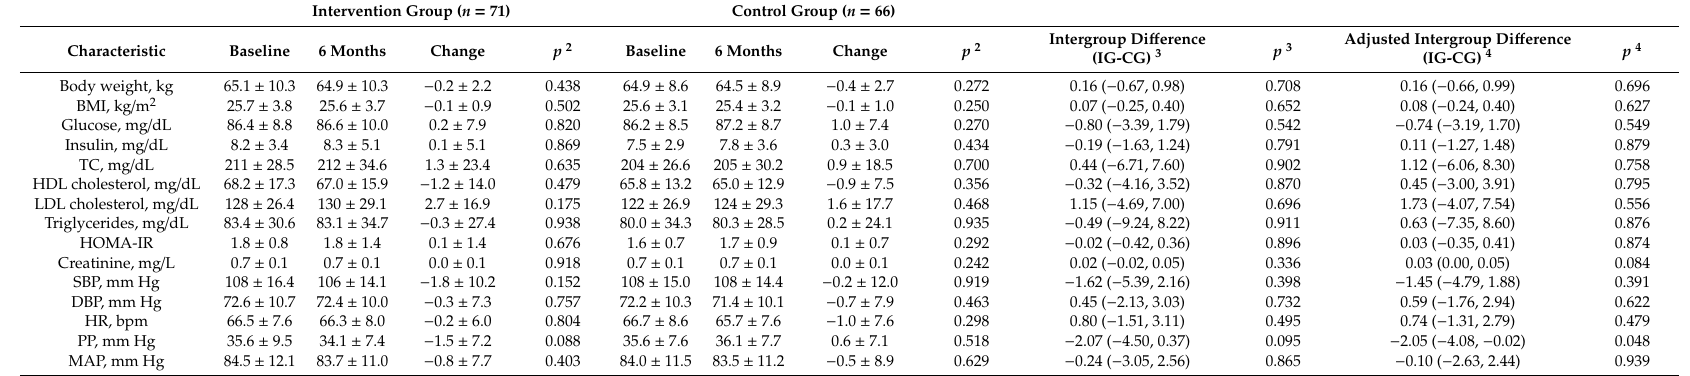
Table 3. Cardiovascular risk factors and blood pressure in postmenopausal women participants 1